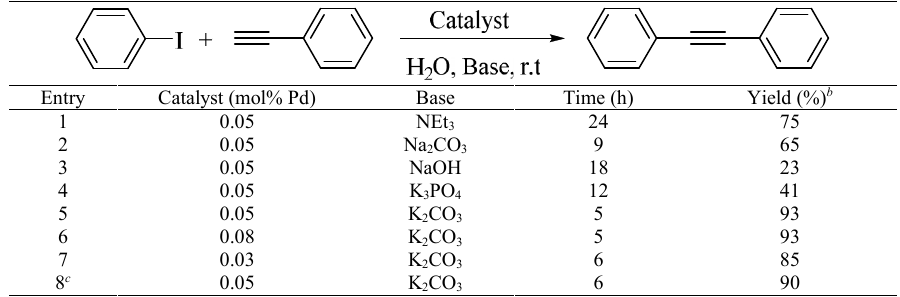
c Reaction was perfomed at 80 °C.